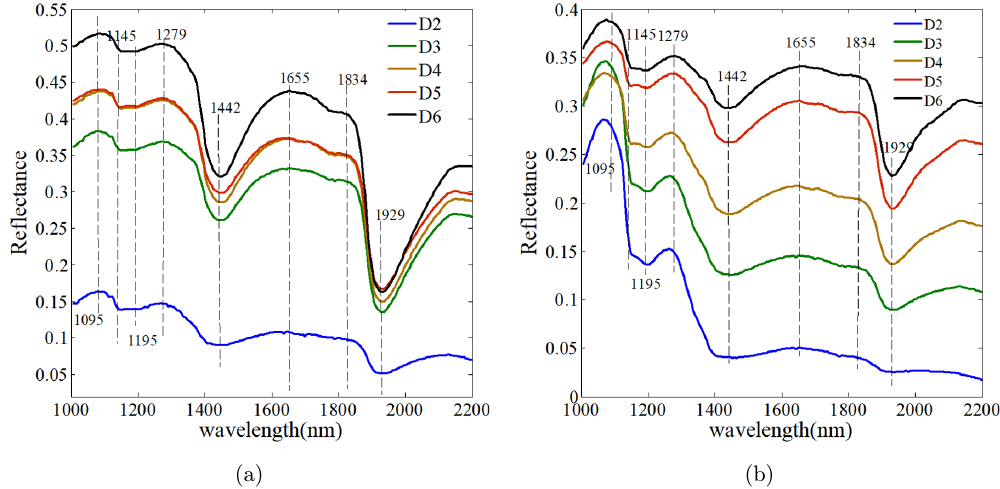
Fig. 4. Average spectra of each colony. (a) Average spectra of colonies on RBM. (b) Average spectra of colonies on MAM.